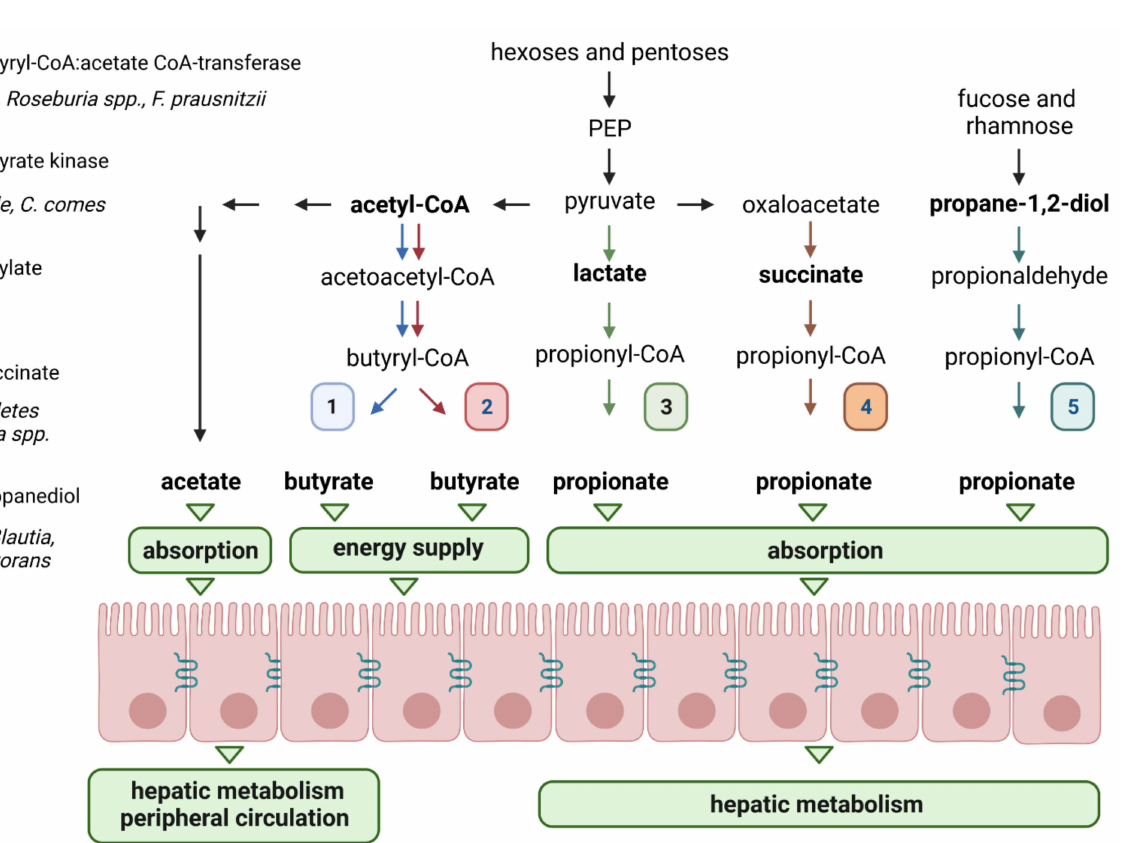
Figure 2. Short-chain fatty acid (SCFA) biosynthesis pathways by the gut microbiota. The different pathways involved in SCFA production are presented for acetate, butyrate, and propionate. SCFA- producing bacteria for each pathway are also shown. Acetate is mainly produced in the gut from pyruvate via acetyl-coenzyme A (CoA). Three pathways have been described for propionate synthesis, namely acrylate, succinate, and propanediol. The first two start from phosphoenolpyruvate (PEP) and the latter uses deoxysugars, such as fucose and rhamnose. Butyrate is produced via two pathways: the butyryl-CoA: acetate CoA-transferase and the butyrate